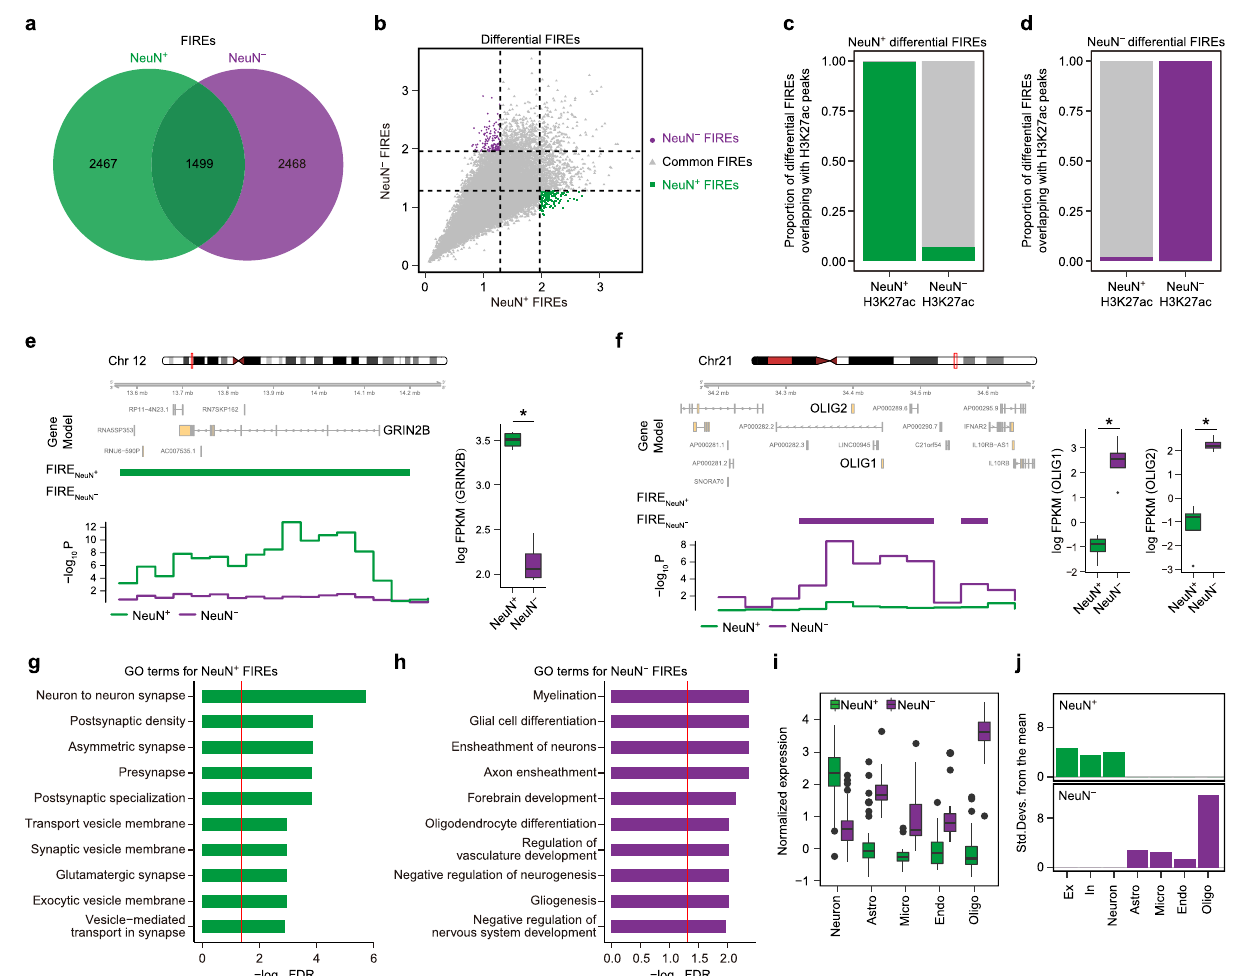
Fig. 1 Differential FIREs are associated with cell-type-speci fi c gene regulation. a The number of FIREs detected in NeuN + and NeuN − cells. b Differential FIREs were identi fi ed in NeuN + and NeuN − cells. c , d Differential FIREs overlap with differential H3K27ac peaks in the corresponding cell types. A neuronal gene, GRIN2B , is located in NeuN + speci fi c FIREs ( e ), while two oligodendrocytic genes, OLIG1 and OLIG2 , are located in NeuN − speci fi c FIREs ( f ). FIREs and signi fi cance of FIRE scores in NeuN + and NeuN − cells are depicted in green and purple, respectively. Boxplots in the right show expression levels of GRIN2B (FDR = 3.71e − 12), OLIG1 (FDR = 7.34e − 26) and OLIG2 (FDR = 8.06e − 23) in NeuN + ( n = 4) and NeuN − ( n = 4) cells. FPKM Fragments Per Kilobase of transcript per Million mapped reads. Center, median; box = 1st to 3rd quartiles (Q); minima, Q1 − 1.5 × interquartile range (IQR); maxima, Q3 + 1.5 × IQR. *FDR < 0.05 calculated by DESeq2 (two-sided Wald test). Source data are provided as a Source Data fi le. Gene ontology (GO) analysis for genes assigned to differential NeuN + ( g ) and NeuN − ( h ) FIREs. The red line denotes FDR = 0.05. i Cellular expression levels of genes assigned to differential NeuN + and NeuN − FIREs. Center, median; box = Q1 − Q3; minima, Q1 − 1.5 × IQR; maxima, Q3 + 1.5 × IQR. Neurons, n = 131; astrocytes (Astro), n = 62; microglia (Micro), n = 16; endothelial (Endo), n = 20; oligodendrocytes (Oligo), n = 38. Source data are provided as a Source Data fi le. j Genes assigned to differential NeuN + and NeuN − FIREs are enriched in neurons and glia, respectively. Ex excitatory neurons, In inhibitory